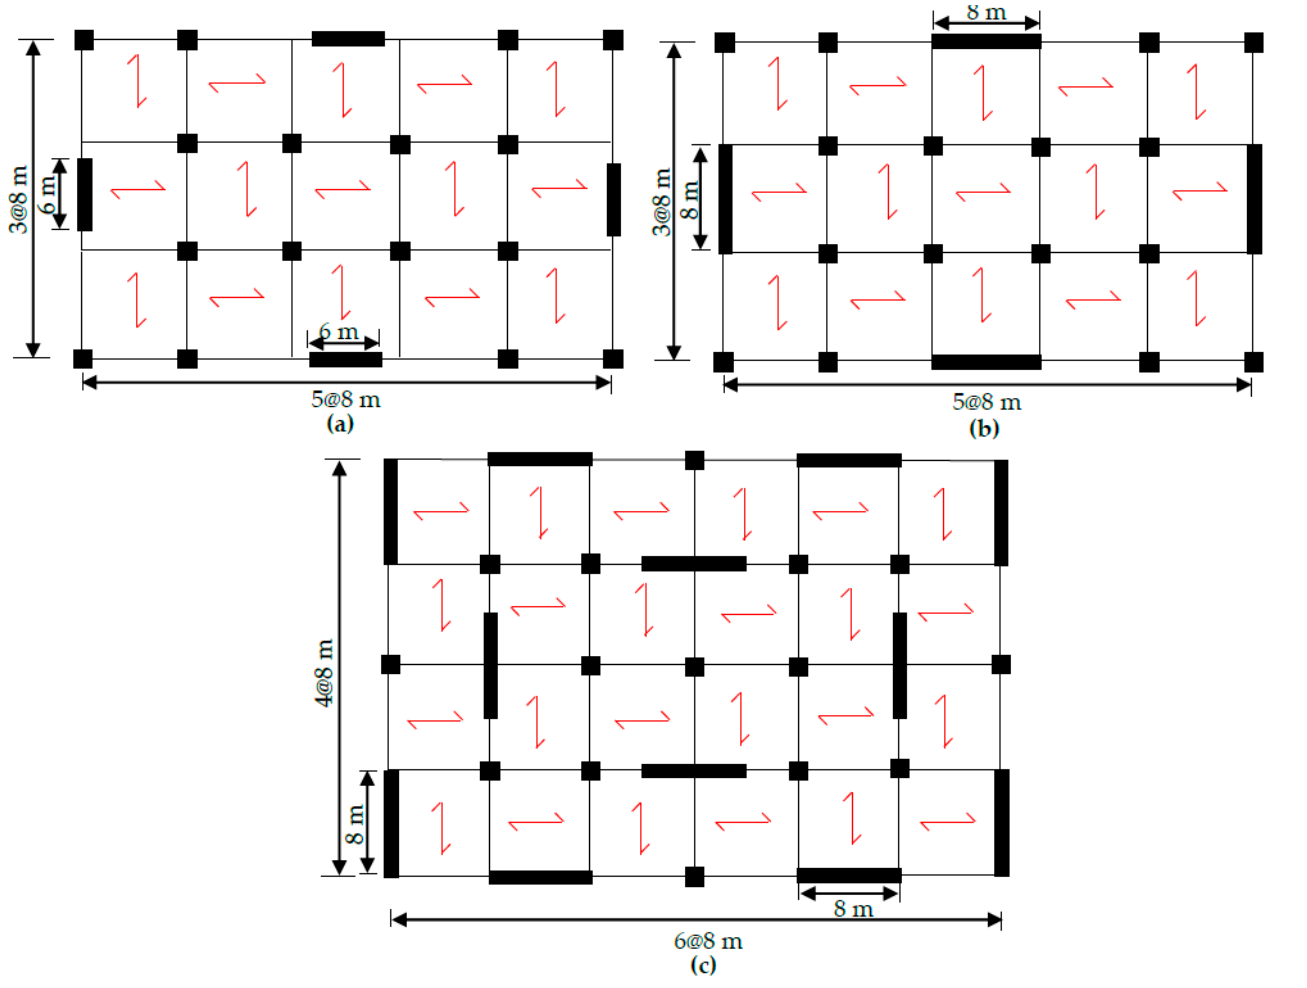
Figure 5. Case study buildings: ( a ) 4-story; ( b ) 8-story; ( c ) 12-story reinforced concrete wall buildings’ layout.